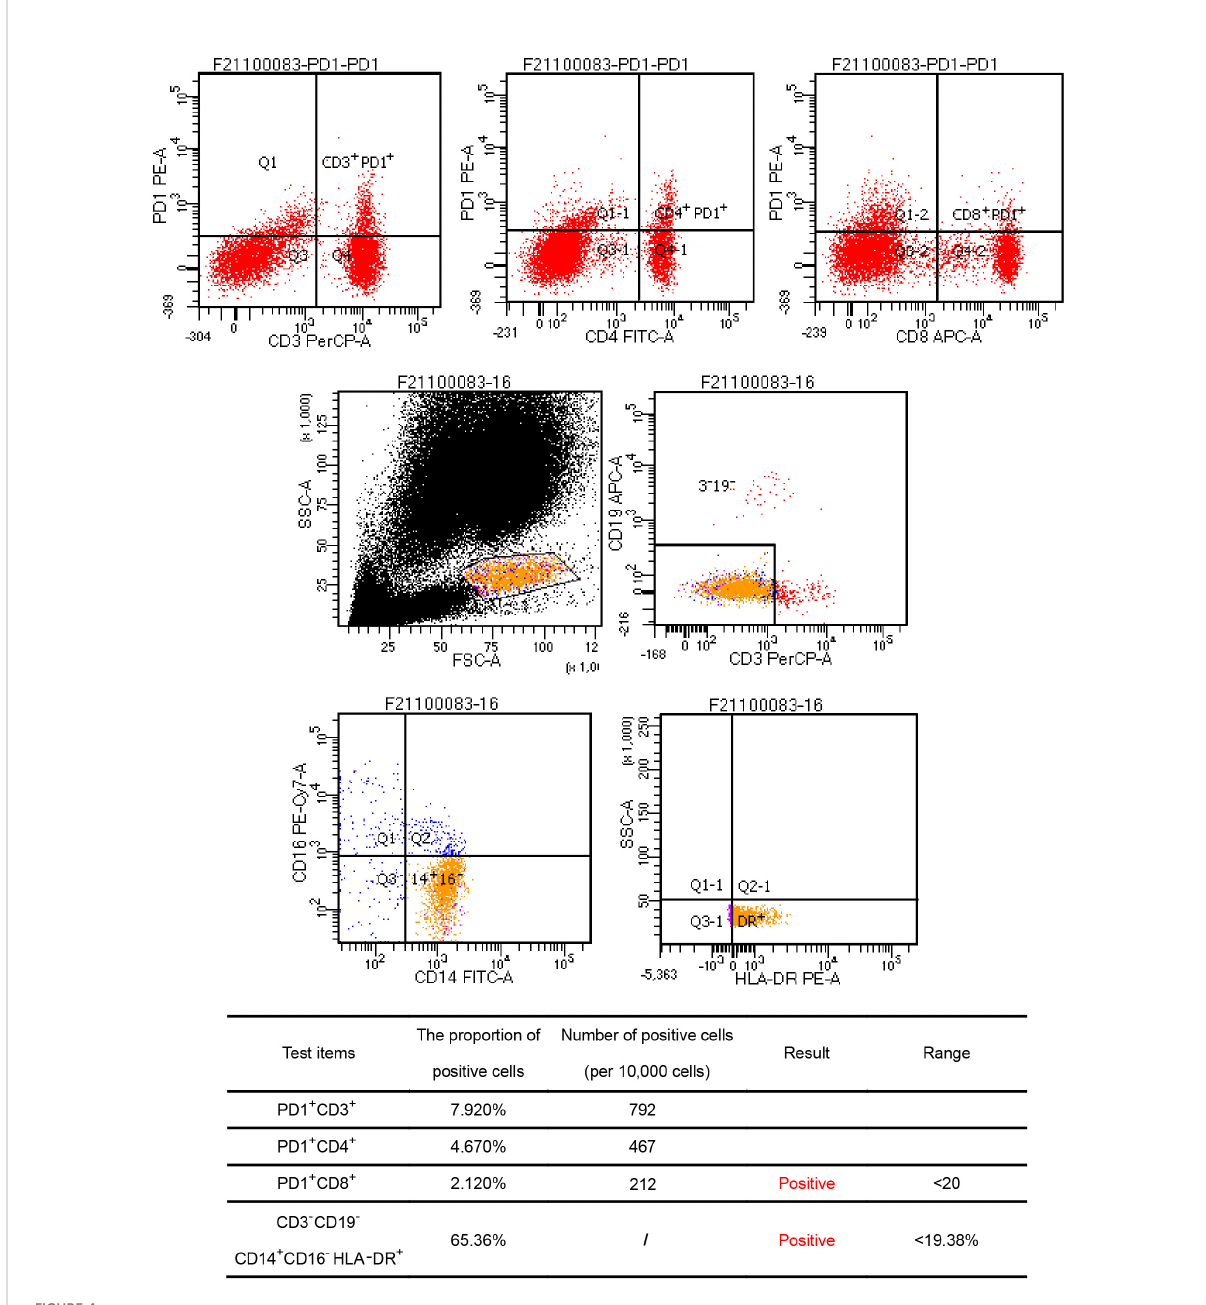
HLA-DR positive cells was 65.36%, and all the above cell numbers were